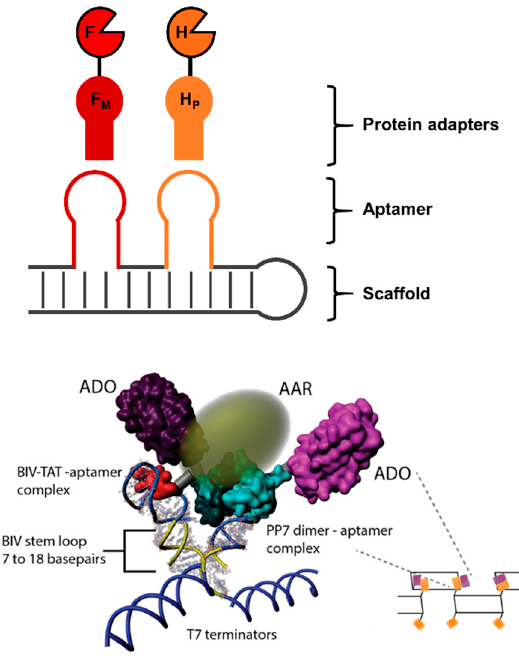
Figure 13. RNA aptamers are important for enzyme scaffolding. ( A ) Fusion of the aptamer binding F M and H P domains to the cargo proteins ferredoxin (F) and hydrogenase (H) allows these enzymes to be coupled to RNA scaffolds. Reproduced from Aldaye and co-workers [22]. ( B ) Proposed model in which the enzymes ADO and AAR are tethered to a two-dimensional RNA scaffold by aptamer binding. Reprinted from Silver and co-workers [148]. Copyright 2014 Oxford University Press.